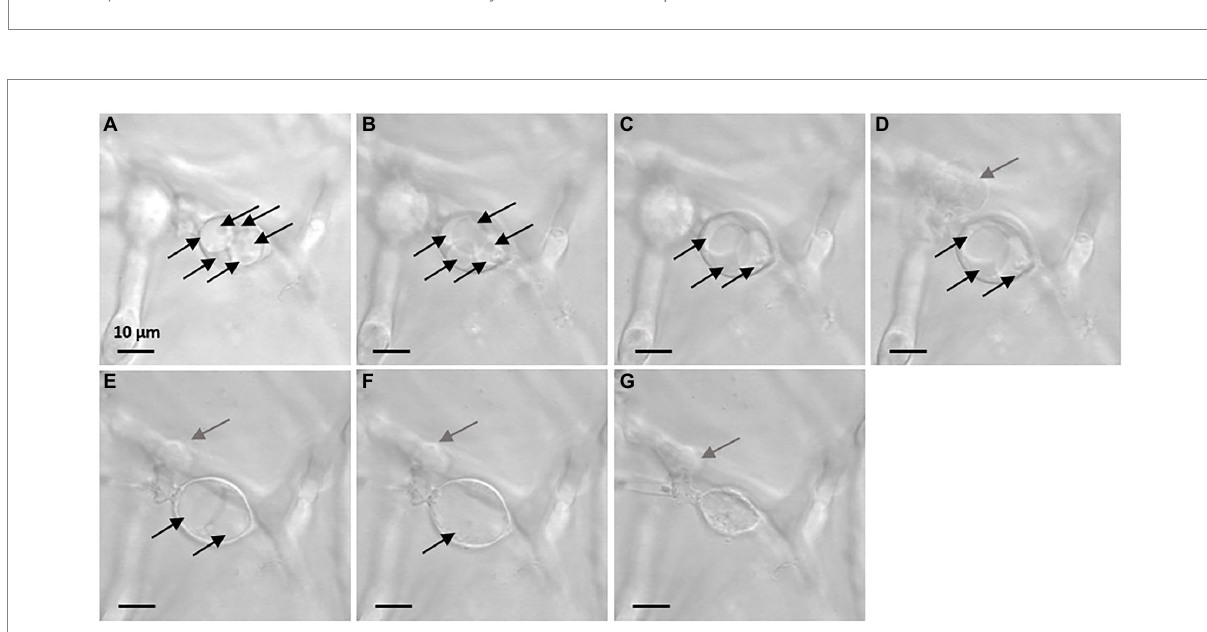
FIGURE 3 Evolution of vesicle-like structures induced by 50 μ g mL − 1 FGs on Ssc51 mycelium over time. The observation at t = 0 h (26 h after adding of FGs in the growth medium) shows 6 vacuoles inside the vesicle-like structure in the center of the picture (A) . At t = 1 h, there were 5 vacuoles (B) . At t = 1 h 49 min, there were 3 vacuoles in the structure (C) . At t = 1 h 57 min, a leakage from another vesicle-like structure was observed on the left of the picture (D) . At t = 4 h 20 min, 2 swollen vacuoles were observed in the central structure (E) . At t = 4 h 23 min, one vacuole remained (F) . At t = 4 h 43 min, the vesicle-like structure bursted and released its cytoplasmic content (G) . Each vacuole is indicated by a black arrow. Gray arrows indicate a leakage. Scale bar: 10 μ m.